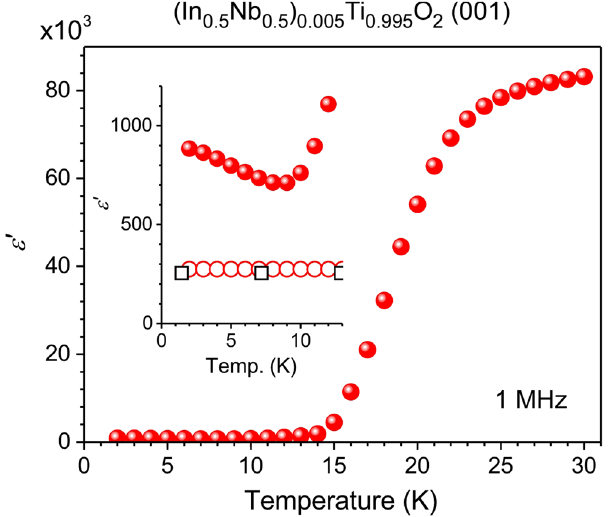
Figure 3. Real part of the dielectric permittivity of a NITO-0.5% single crystal with a (001) wide surface measured at 1 MHz and shown as a function of temperature by closed circles. The inset shows a magnified view of the temperature region below 13 K. The open circles indicate the real part of the dielectric permittivity of pure TiO 2 observed in the present study. The previous result of the real part of the dielectric permittivity of pure TiO 2 in ref. 29 are plotted by the open squares for